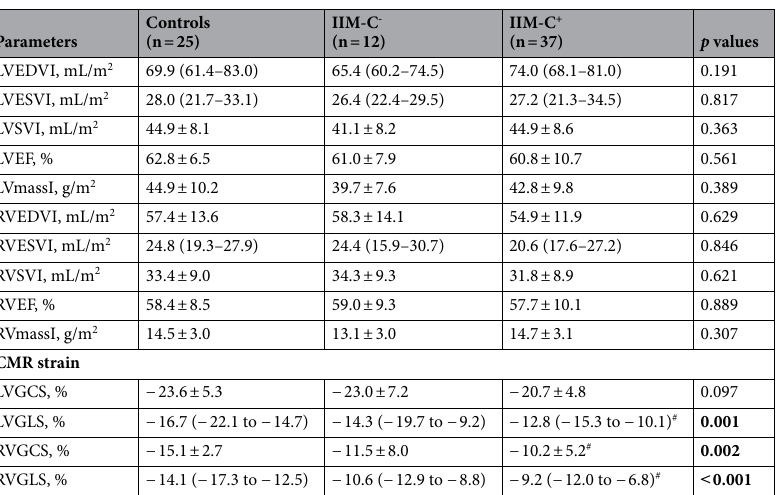
Table 2. CMR volume and functional parameters of controls, IIM patients without and with myocardial involvement. Data are expressed mean ± standard deviation, or median (interquartile range). Bold value denotes p < 0.05 for ANOVA or Kruskal–Wallis test. IIM, idiopathic inflammatory myopathy; CMR, cardiac magnetic resonance; LV, left ventricle; EDVI, end-diastolic volume index; ESVI, end-systolic volume index; SVI, stroke volume index; EF, ejection fraction; massI, mass index; RV, right ventricle; GCS, global circumferential strain; GLS, global longitudinal strain. # Indicates adjusted p < 0.05 for controls versus IIM-C + . § Indicates adjusted p < 0.05 for controls versus IIM-C − . & Indicates adjusted p < 0.05 for IIM-C − versus IIM-C + .